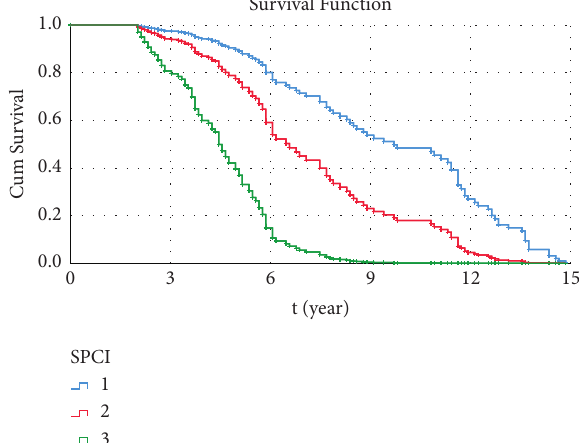
Figure 3: Survival curves for each level of the superstructure.